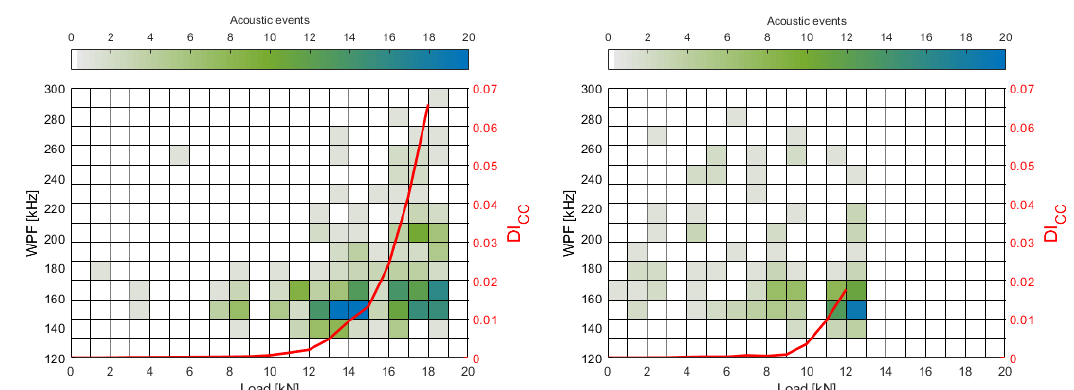
Figure 6. Combination of AE and guided wave measurements. The damage index DI CC (red line) and the recorded acoustic events (color-coded) vs. the load levels and the WPF are plotted. Left : 0/90 test specimen 2–20. Right : +45/ − 45 test specimen 1–10.